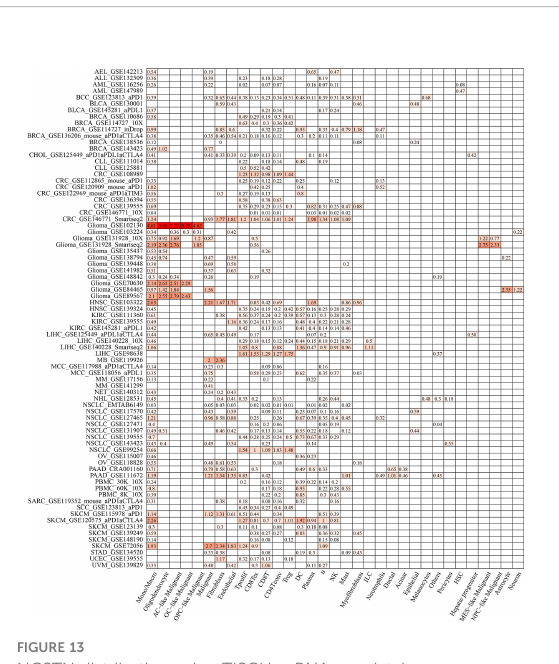
FIGURE 12 ACTR2 distribution using TISCH scRNA seq database.